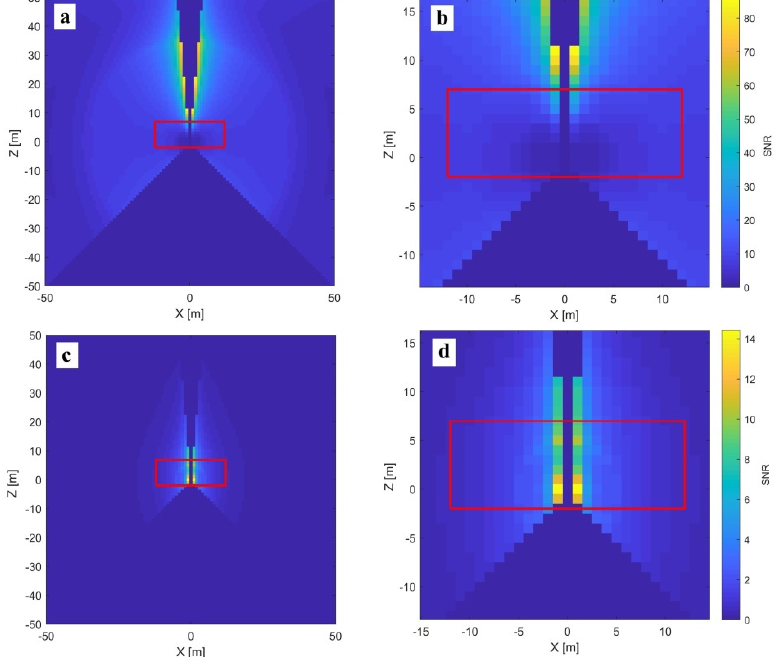
Figure 10. SNR for 𝑥 (cid:2869)(cid:3041)(cid:2878)(cid:2870) in a vertical plane—full field of view (left) and the close-up (right).